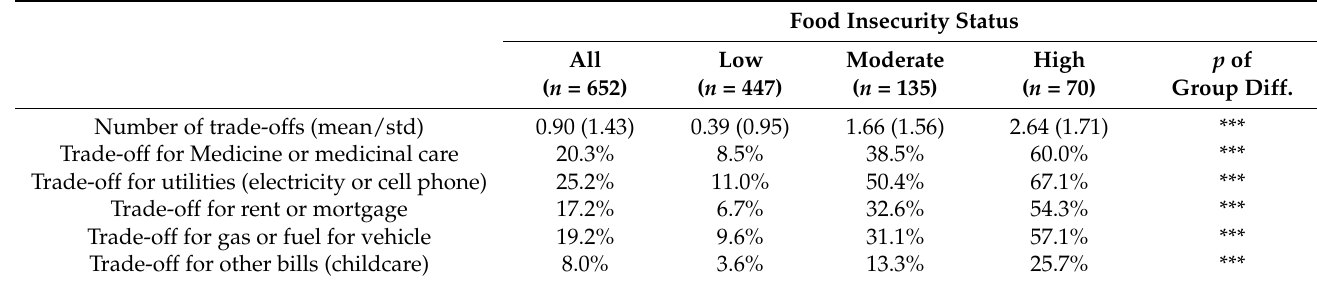
Table 2. Number and type of trade-offs by food insecurity